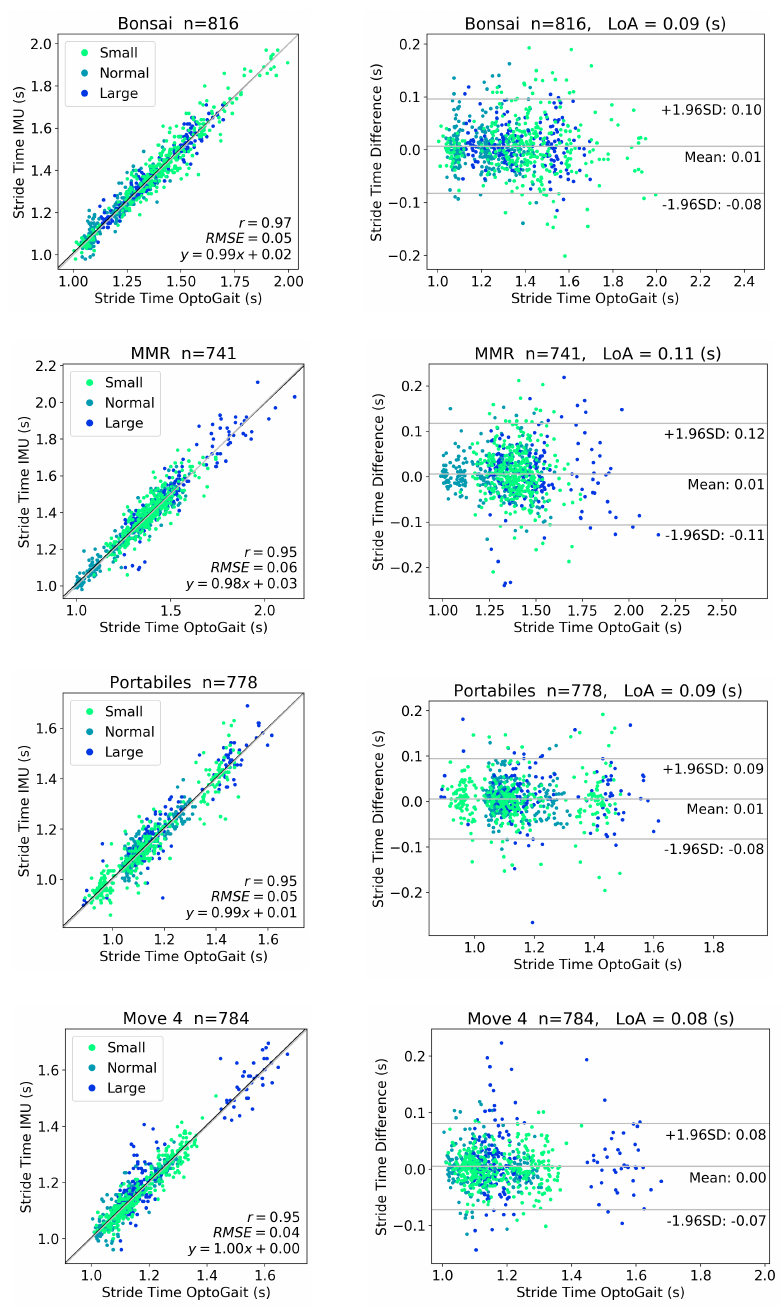
Figure A1. Correlation analysis and Bland–Altman plots of stride times from IMU and OptoGait. r: correlation coefficient, RMSE: root mean square error, LoA: average limits of agreement at ± 1.96 standard